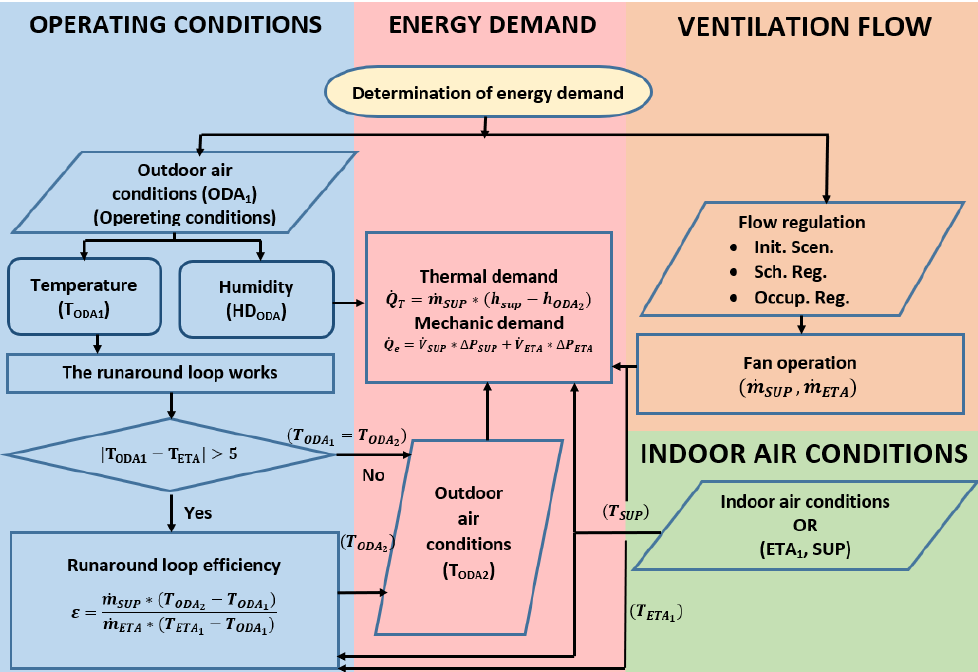
Figure 7. Flow Chart used to Assess the Thermal and Electrical Energy Demand of the Operating Rooms.